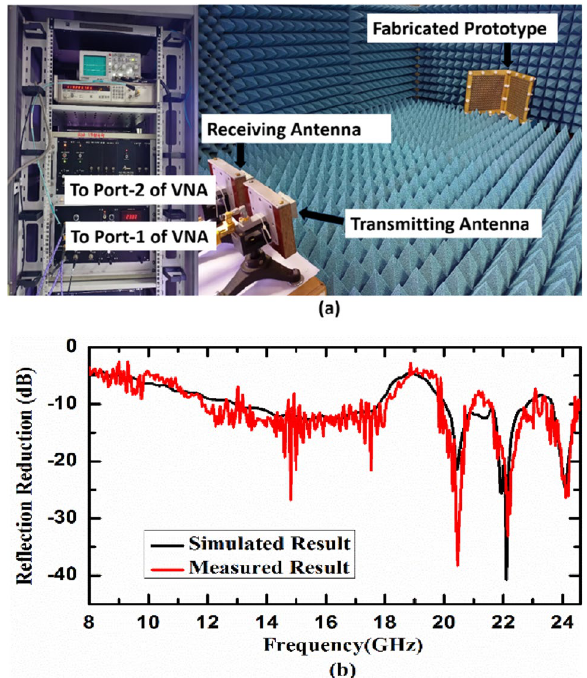
Figure 14. ( a ) Experimental setup for 90° dihedral metasurface and ( b ) simulated and measured reflection reduction of the developed 90° dihedral metasurface under normal